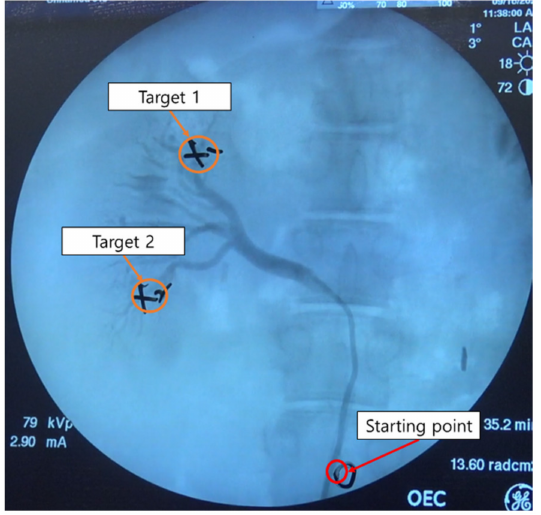
Figure 12. Starting and target points of pig right renal artery